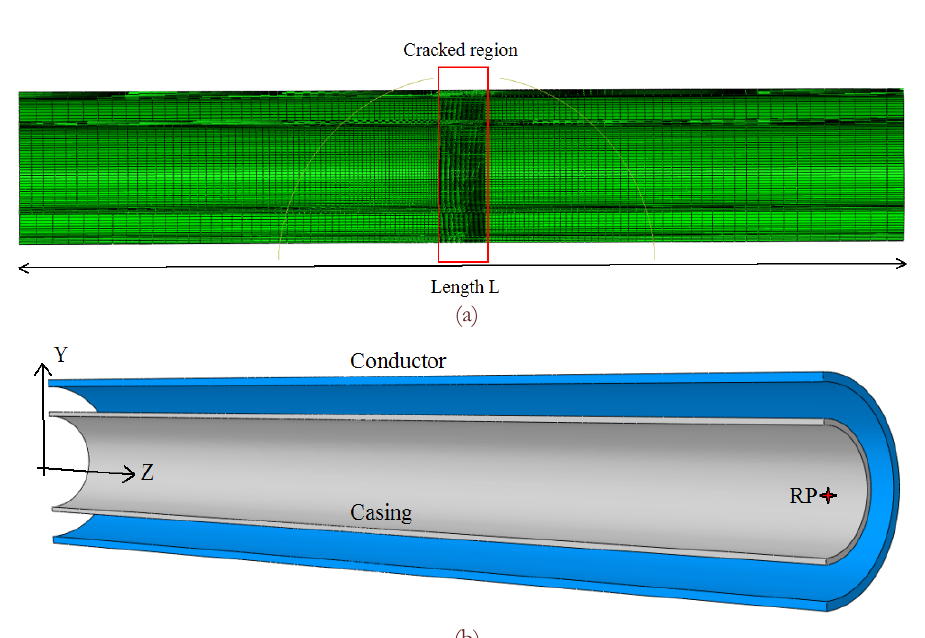
Figure 2: Numerical model of wellhead system: (a) full-system (A refined mesh was used in the cracked region; the crack is placed at L/2); (b) cross section of conductor/casing system in this